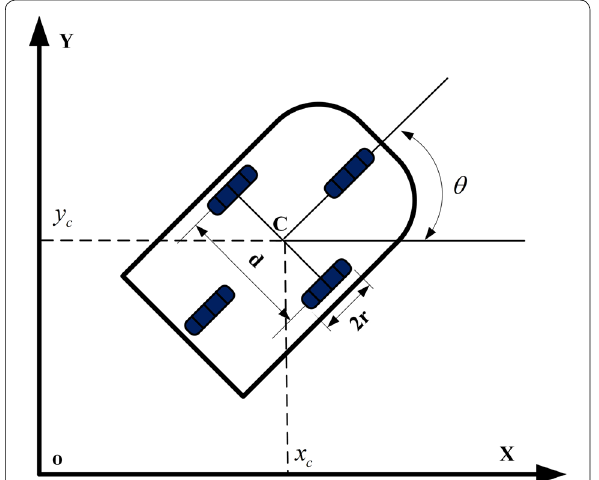
Figure 1 Overview of the mobile robot